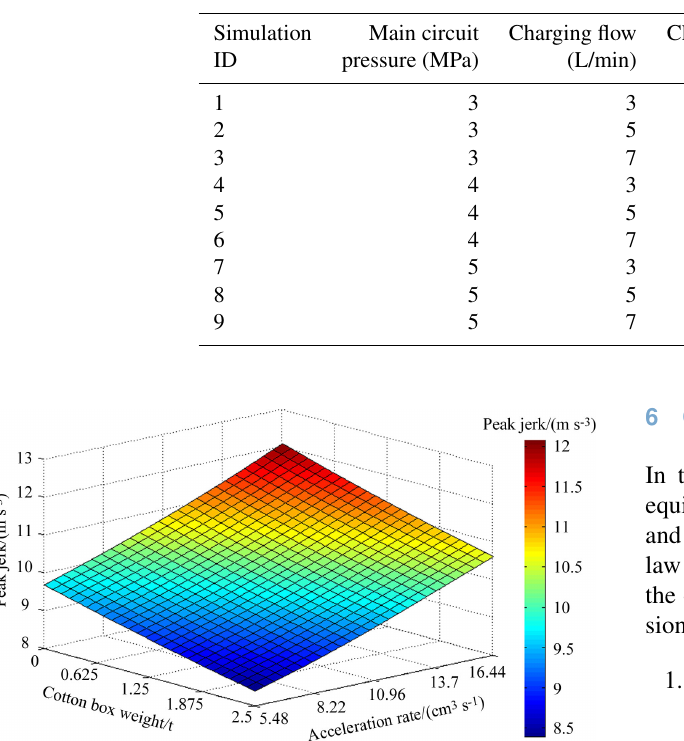
Figure 12. Optimized shift quality of the cotton